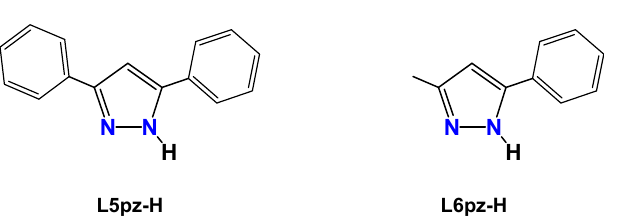
Figure 2. Pyrazoles used in this research. Table 1. Structural parameters of selected cyclic trinuclear pyrazolato Copper(I) complexes.